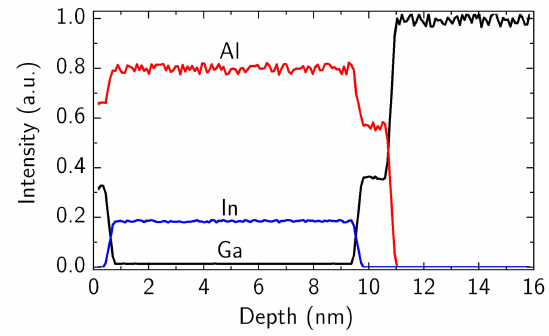
Figure 2. SIMS profile of Ga, In, and Al in the heterostructure under